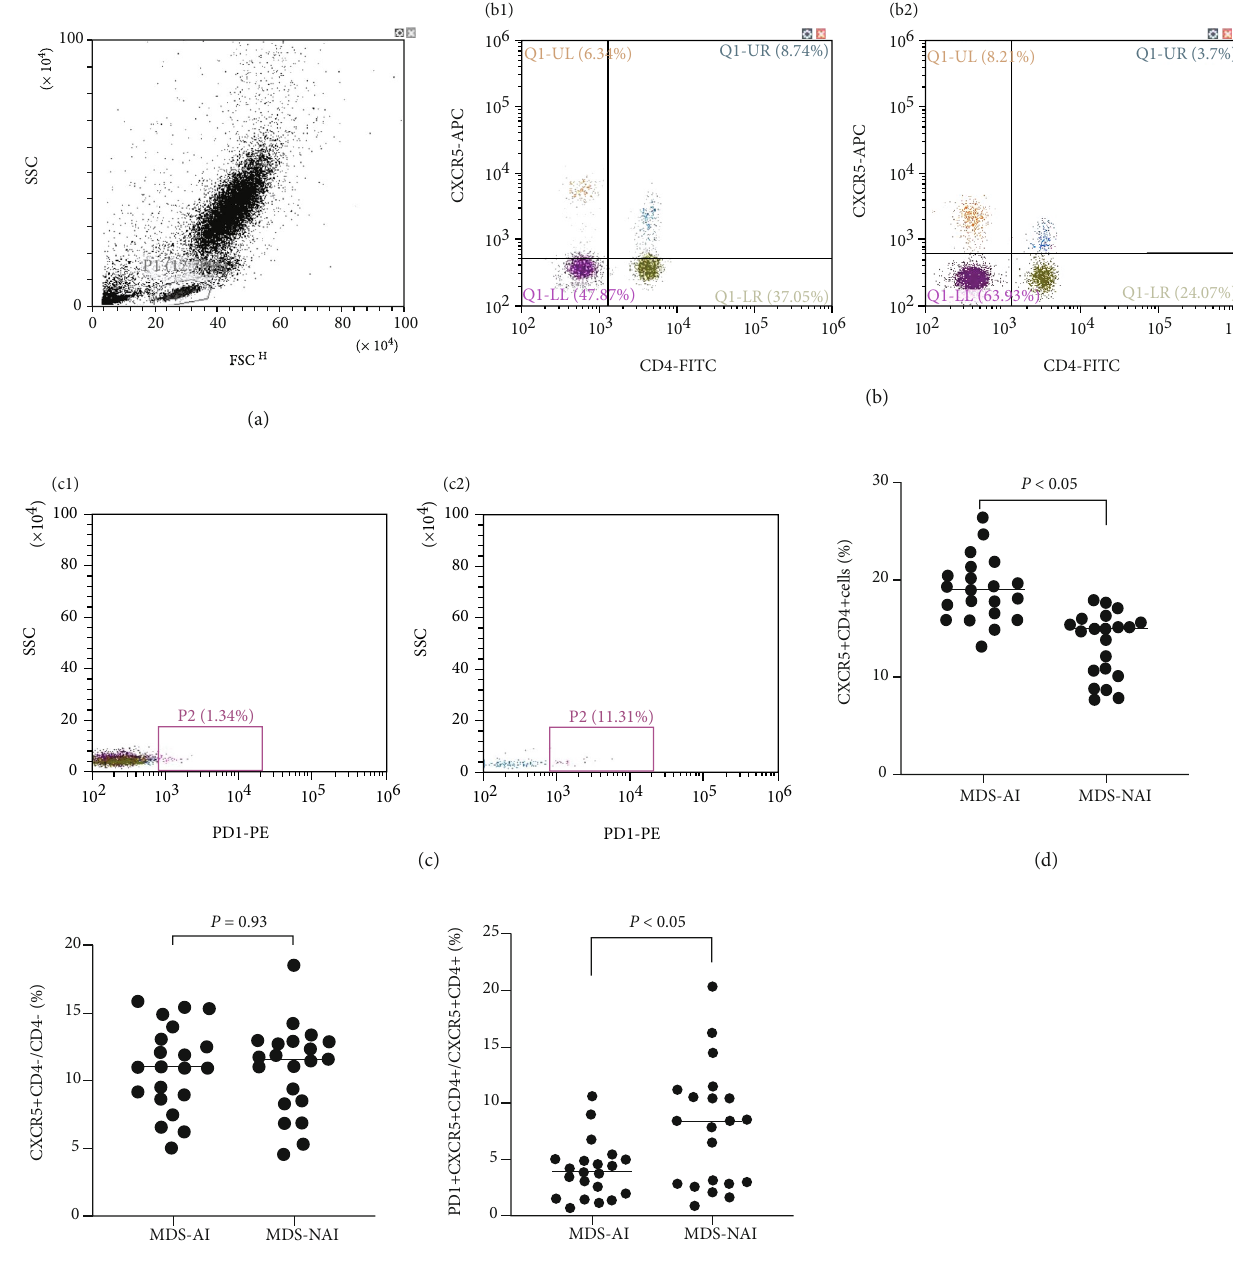
Figure 1: Increased frequency of CD4 + CXCR5 + lymphocytes in the peripheral blood of newly diagnosed MDS patients with autoimmune disease (MDS-AI). (a) The gate of lymphocyte population in the peripheral blood with forward scatter (FSC) and side scatter (SSC). (b) Representative dot plots from fl ow cytometric (FACS) analyses showing the CD4 + CXCR5 + lymphocyte frequency among peripheral blood obtained from newly diagnosed MDS-AI (B1) and newly diagnosed MDS patients without autoimmune disease (MDS-NAI) (B2). (c) Representative dot plots from FACS analyses showing the PD1 expression of CD4 + CXCR5 + lymphocyte frequency among peripheral blood obtained from MDS-AI (C1) and MDS-NAIs (C2). (d) Frequency of CD4 + CXCR5 + lymphocytes from peripheral blood was compared between MDS-AI ( N = 21 ) and MDS-NAI ( N = 21 ). (e) Frequency of CD4 - CXCR5 + lymphocytes from peripheral blood were compared between MDS-AI ( N = 21 ) and MDS-NAI ( N = 21 ).(f) Frequency of PD1 on CD4 + CXCR5 + lymphocytes from peripheral blood was compared between MDS-AI ( N = 21 ) and MDS-NAI ( N = 21 ). The bars represent the standard error of the